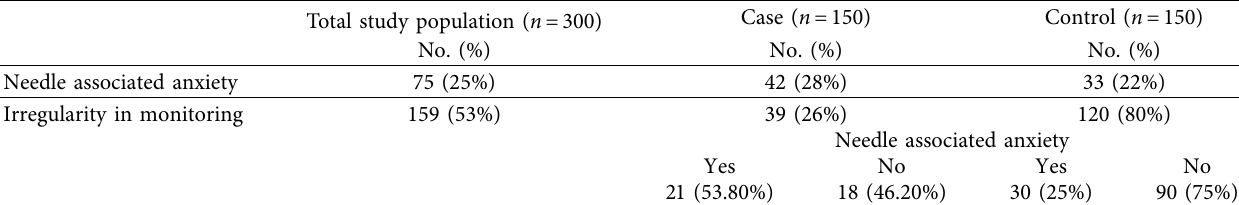
Table 2: Needle associated anxiety and irregularity in blood monitoring in subjects.